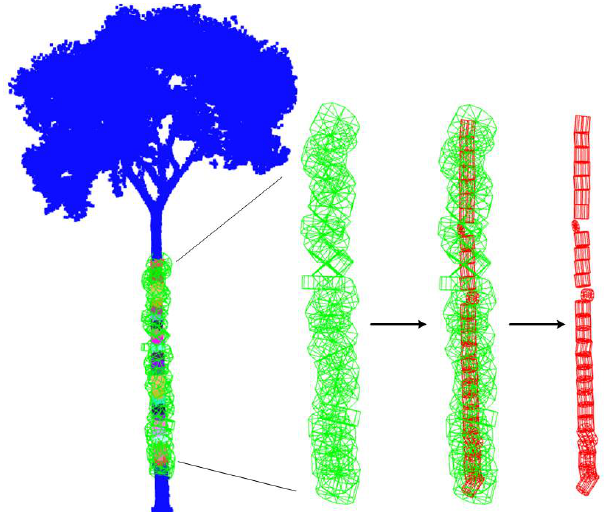
Figure 8. Generate all cylinders participating in the clustering initial cylinder radius from the labeled point cloud. Green represents a rough cylinder that participated in two optimizations by nonlinear least square method. The red represents the optimized cylinder, which will be used for clustering to fit the initial cylinder radius of the